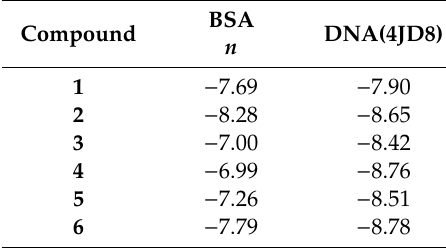
Table 3. Docking energy of compounds 1 – 6 to DNA. Quenching constants and binding constants of compounds 1 – 6 to